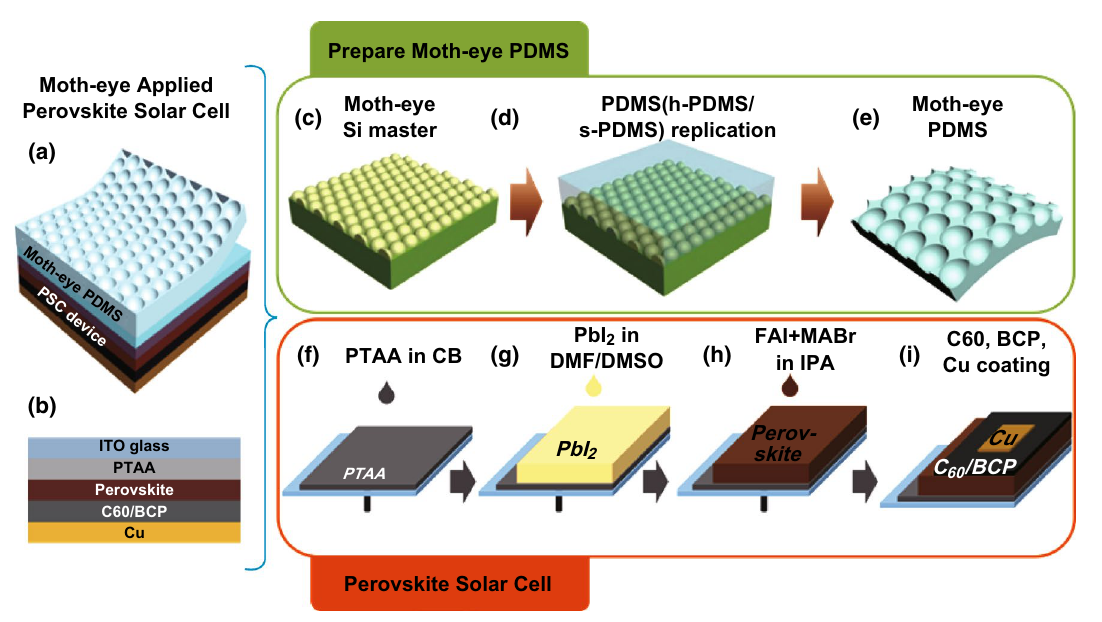
Fig. 1 Representative schematic images of a completed PSC with moth‑eye layer and b PSC configuration. c Fabrication of the hexagonally packed moth‑eye array on a silicon wafer. d Replication of the master structure by successive coating and thermal curing of h‑PDMS and s‑PDMS. e Completed moth‑eye PDMS film. f Spin‑coating deposition of PTAA hole transport layer on ITO/glass substrate. g Spin‑coating deposition of